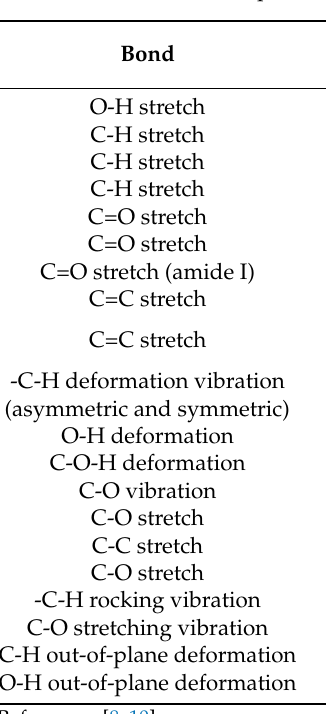
Figure 2. Near-infrared absorption band locations. Reproduced with permission from Metrohm AG, Herisau, Switzerland. Table 1. Mid-infrared absorption bands for a range of bonds important for food